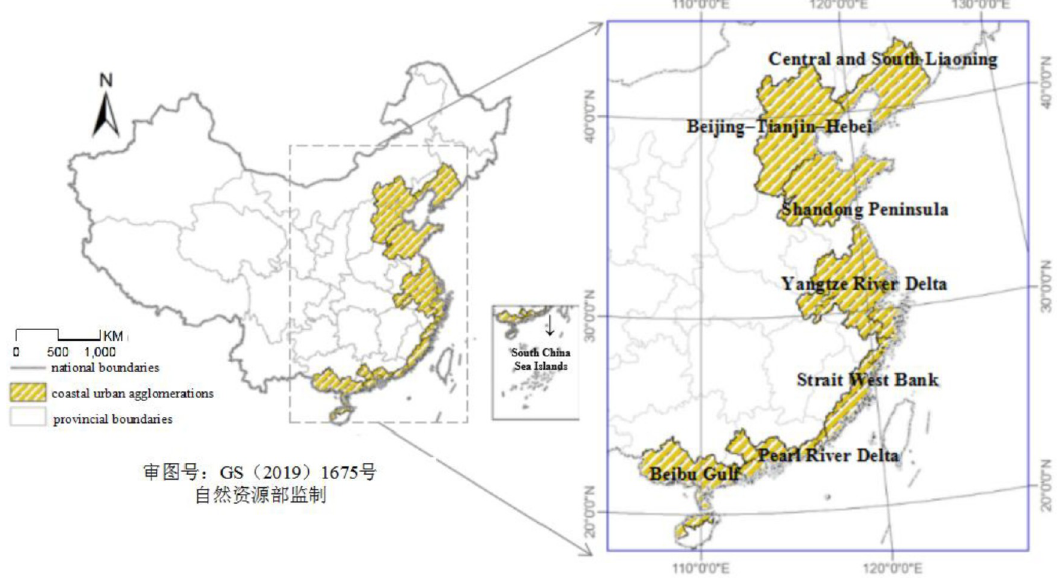
Fig 1. Maps showing the study area, which included seven major urban agglomerations in